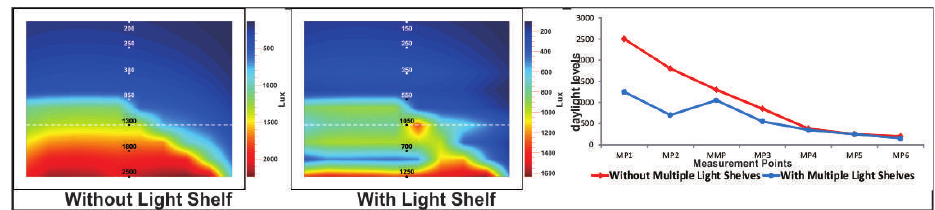
Fig. 10. Comparison of light distribution at 7 a.m.